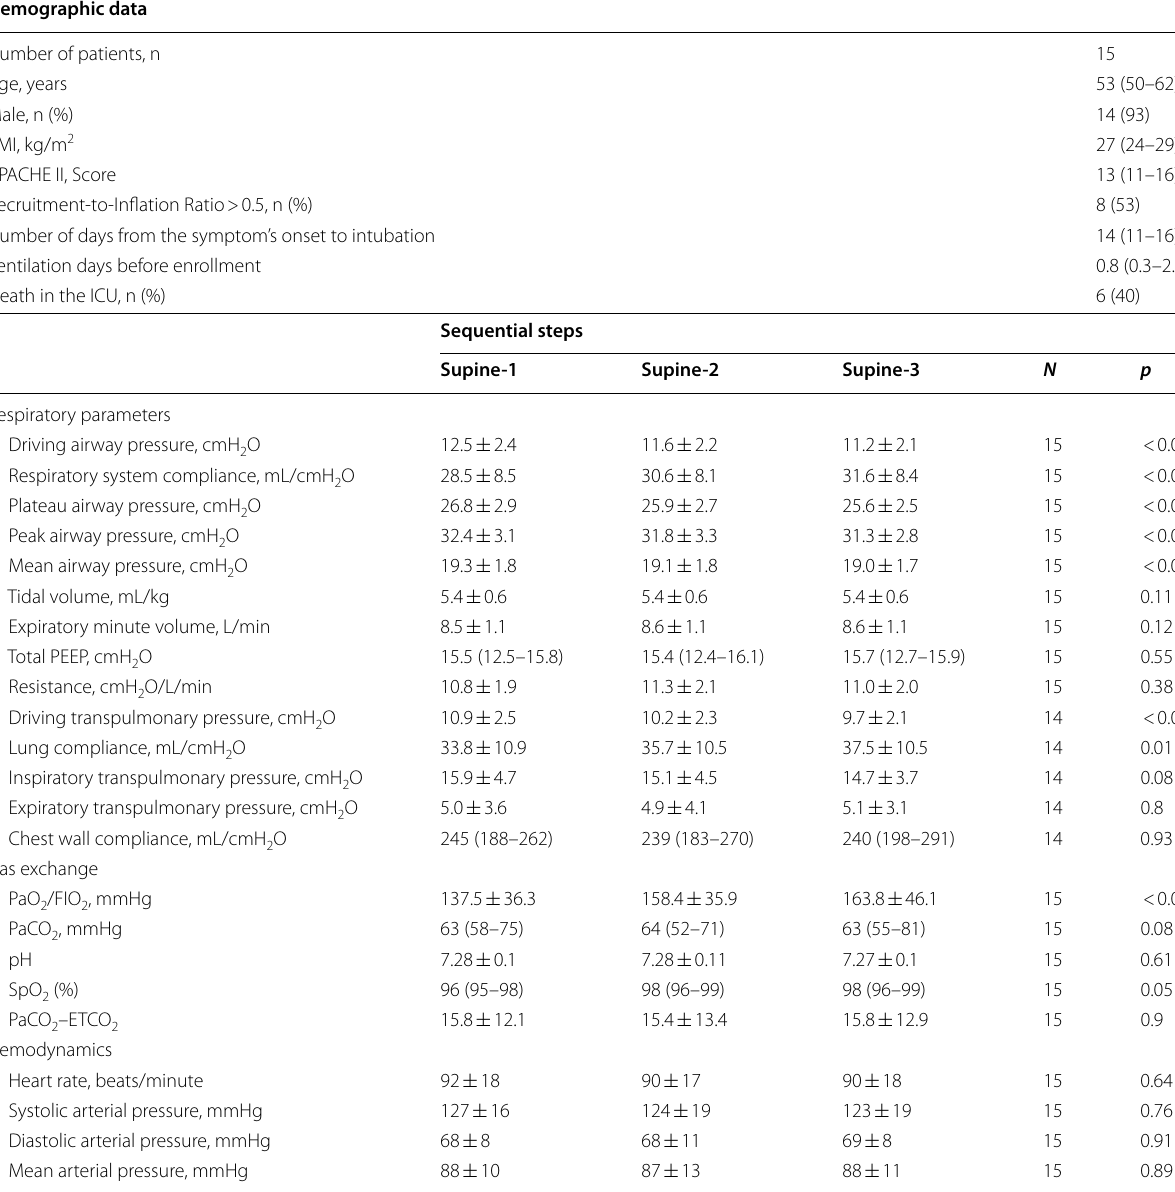
Table 1 Demographic, respiratory and hemodynamics